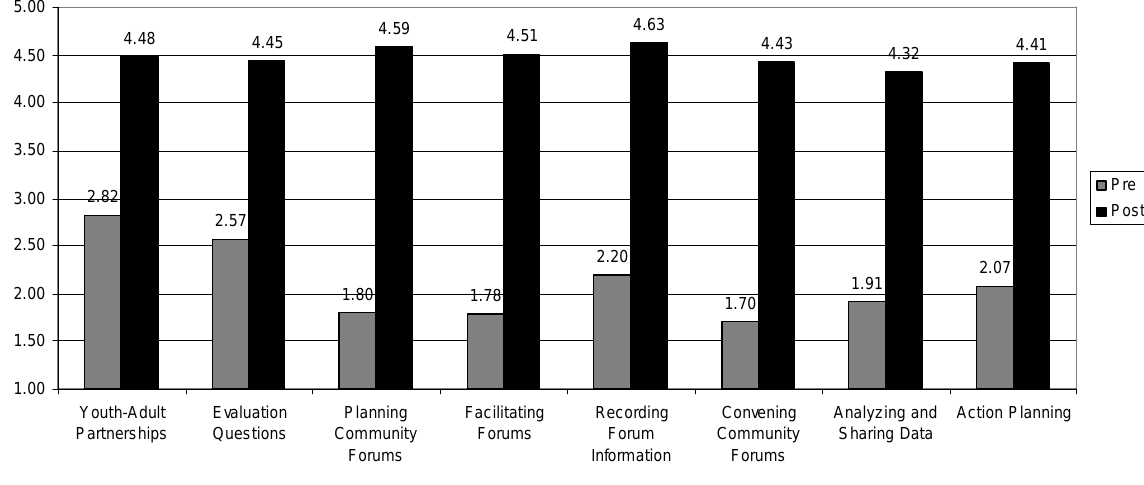
Change in participant knowledge of training topics pre to post (n =